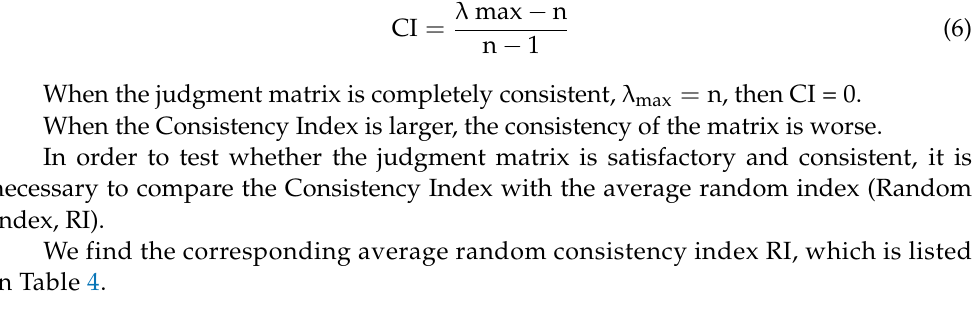
Table 4. Average random consistency index value of